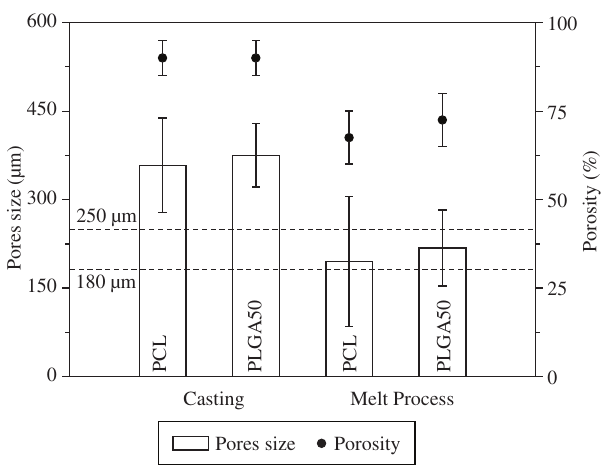
Figure 3. Average of pore sizes ( µ m) and average porosity (%) of PCL and PLGA50 scaffolds prepared by casting and melting compression process.